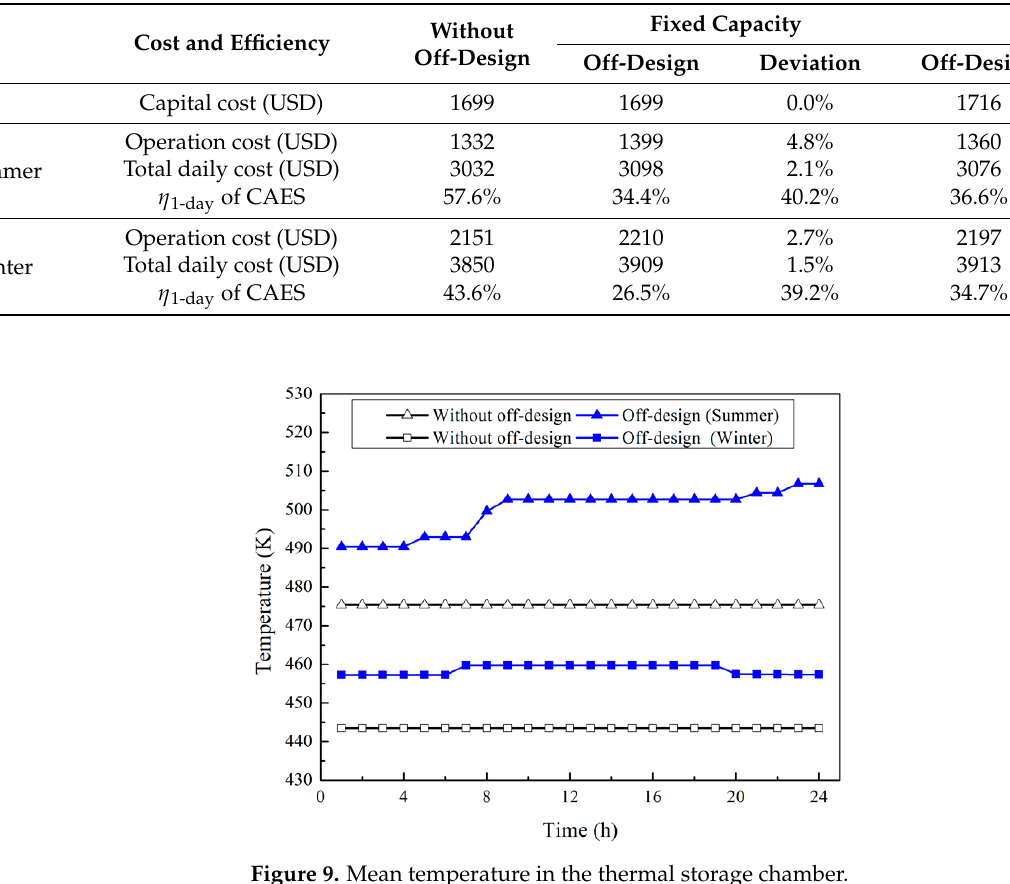
Table 5. Optimal results.